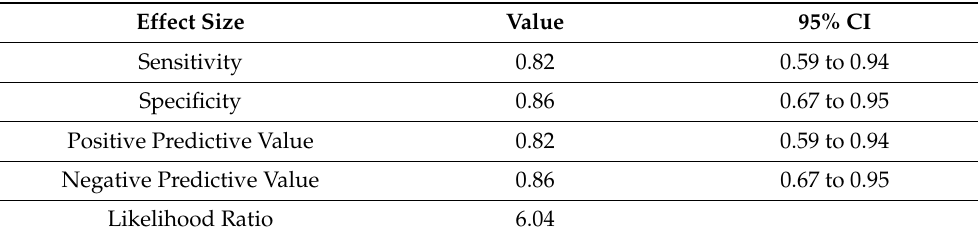
Table 4. Diagnostic performance for eosinopenia and RT-PCR the day of suspicion.